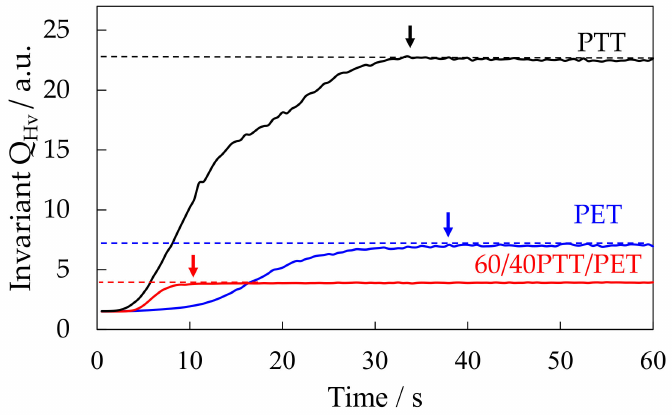
Figure 4. Time variation of invariant Q Hv for 60 / 40 PTT / PET and neat component polymers during isothermal annealing at 180 ◦